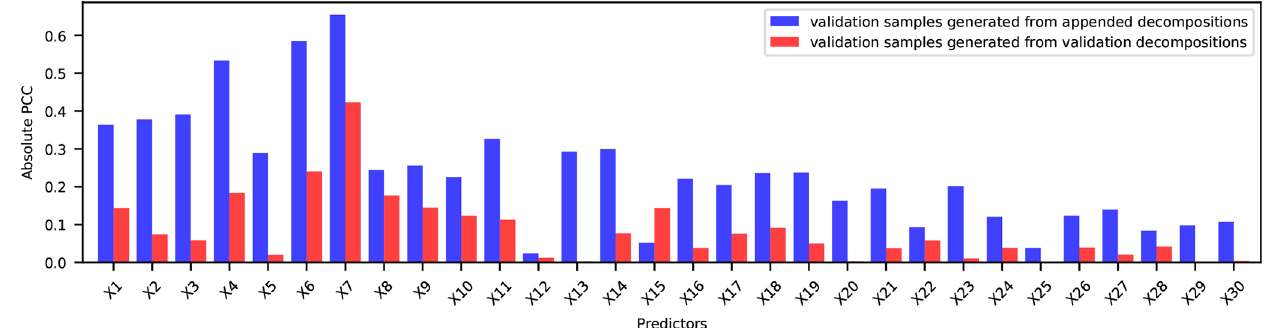
Figure 5. Absolute Pearson correlation coefficients (PCCs) between predictors and predicted targets of validation samples generated from the VMD-appended decompositions and validation decompositions. The samples were collected at the Huaxian